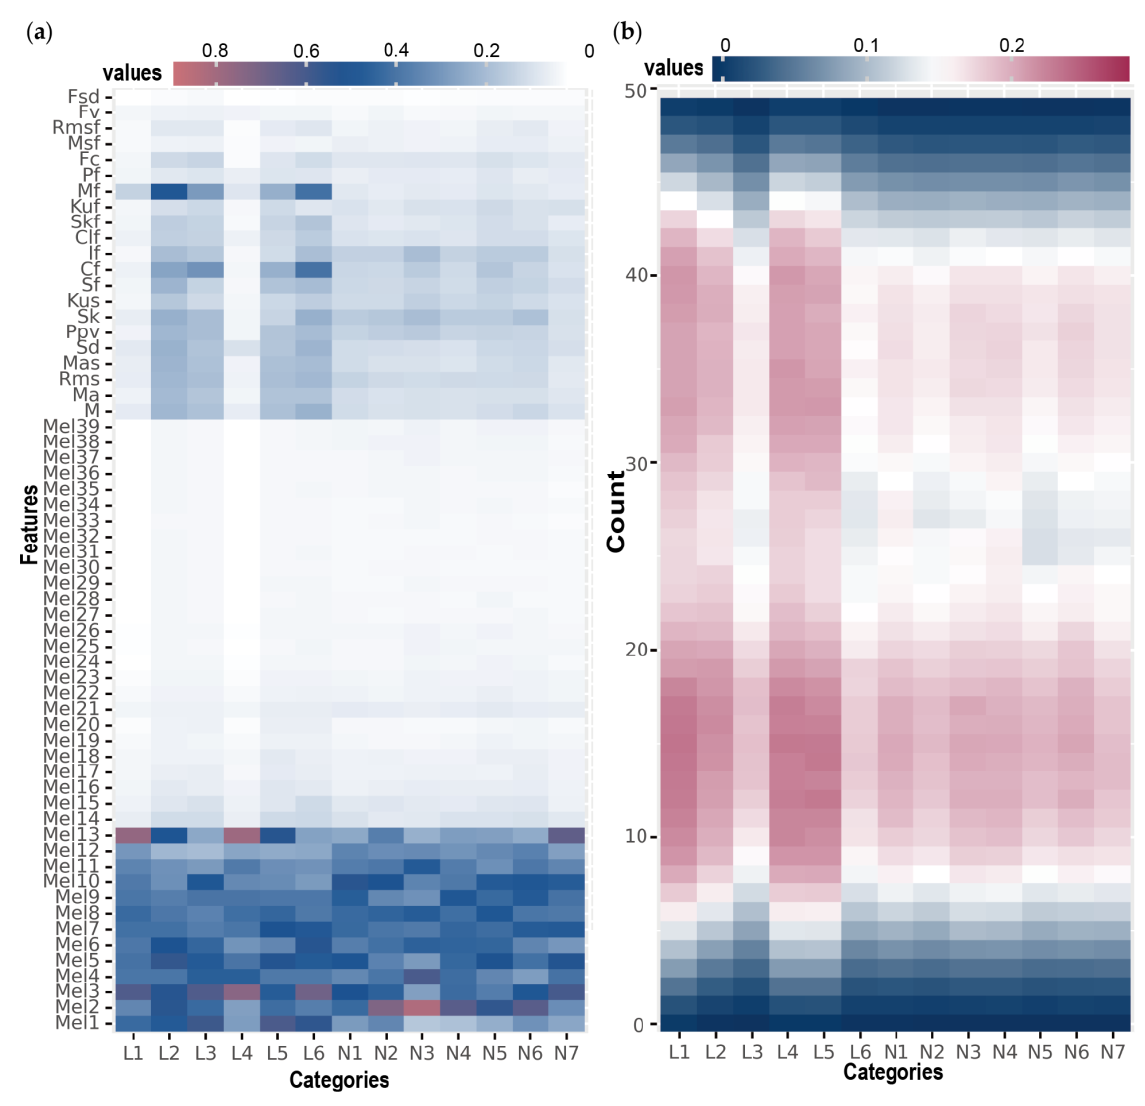
Figure 16. Saliency map of PCNN: ( a ) Saliency map for the input handcrafted features; ( b ) Saliency map for the input raw signals. The saliency value of each raw signal sample is averaged over every 80 points. Then, the category mean values were used to reflect the important regions for leak iden- tification.